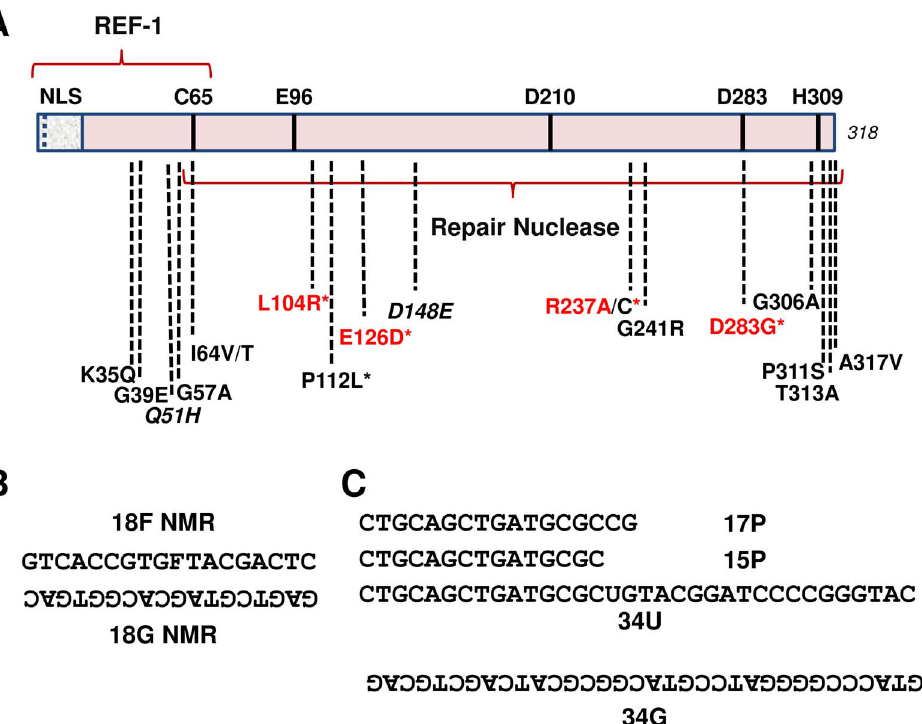
Figure 1. APE1 protein variants and oligonucleotide substrates. ( A ) Linear schematic of the 318 residue APE1 protein, including several reported amino acid substitutions. NLS=nuclear localization sequence; REF-1=redox regulatory portion of the protein; italics=polymorphic variants; *=unique disease-associated variants; red text=variants with reduced AP endonuclease activity. The repair nuclease domain and several functionally important amino acids (C65, E96, D210, D283 and H309) are indicated. See Table 1 for additional details. ( B ) The 18F NMR and 18G NMR oligonucleotides were used to design the double-stranded AP endonuclease substrate. ( C ) The 15P or 17P oligonucleotide was annealed to the 34G oligonucleotide to generate a 3 9 -recessed exonuclease/repair substrate, whereas the 34U oligonucleotide was annealed to 34G to create the uracil- containing duplex for the reconstitution assay. Oligonucleotides are written 5 9 to 3 9 , with the non-labeled strands written upside-down. F=the AP site analog,